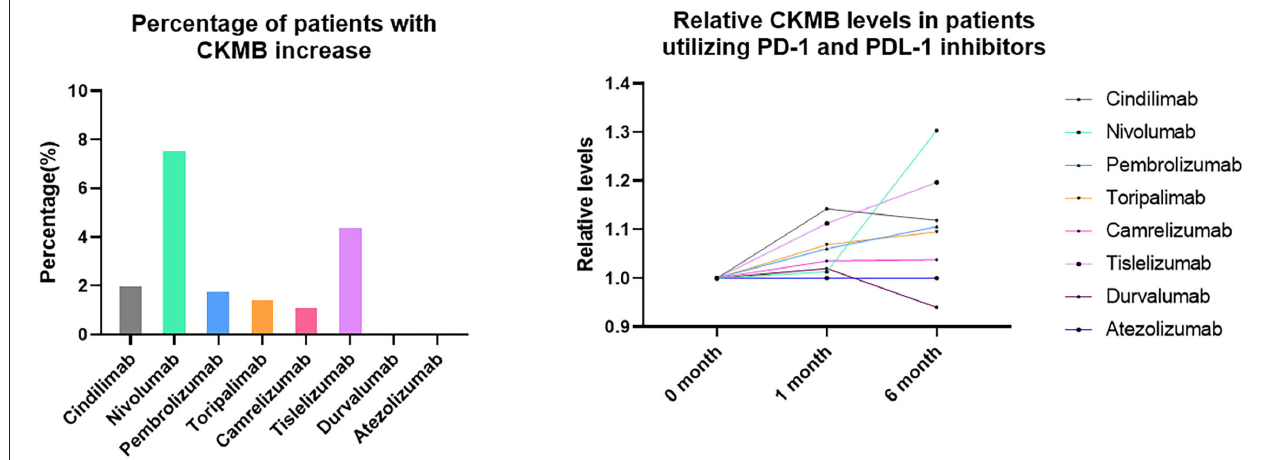
FIGURE 2 | Percentage of patients with CKMB increase and relative CKMB levels in patients utilizing PD-1 and PDL-1 inhibitors.